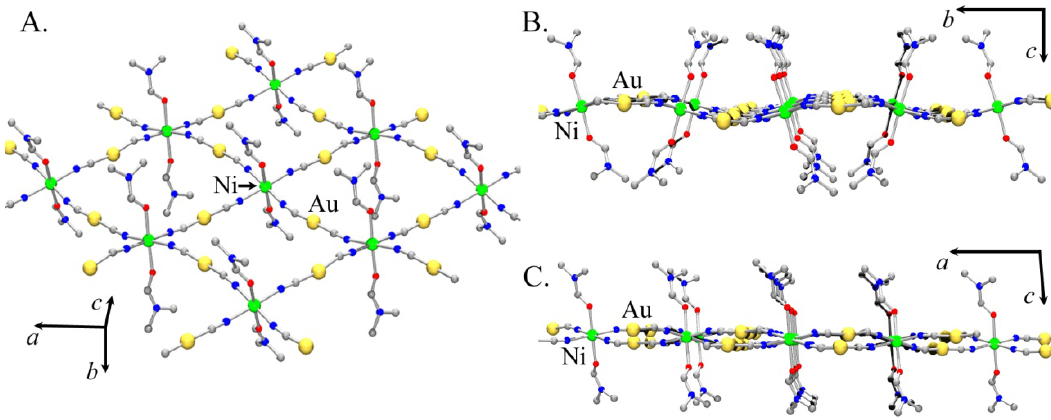
Figure 6. Structural model proposed for Ni[Au(CN) array with DMF molecules coordinated on both sides of the Ni[Au(CN) ( C ). Side-view of a layer showing the relative position of the [Au(CN) to the Ni(II)